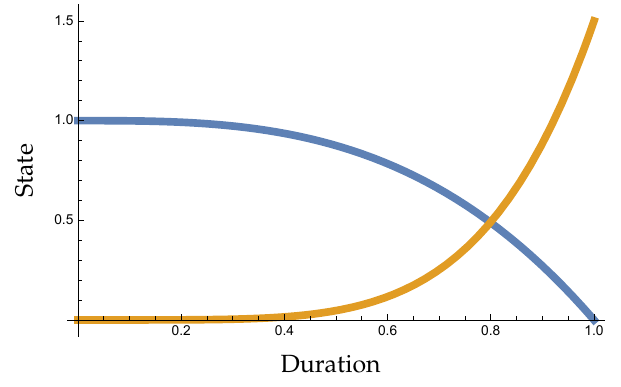
Figure 3. a ( r ) (Brown) and d ( r ) (Blue)